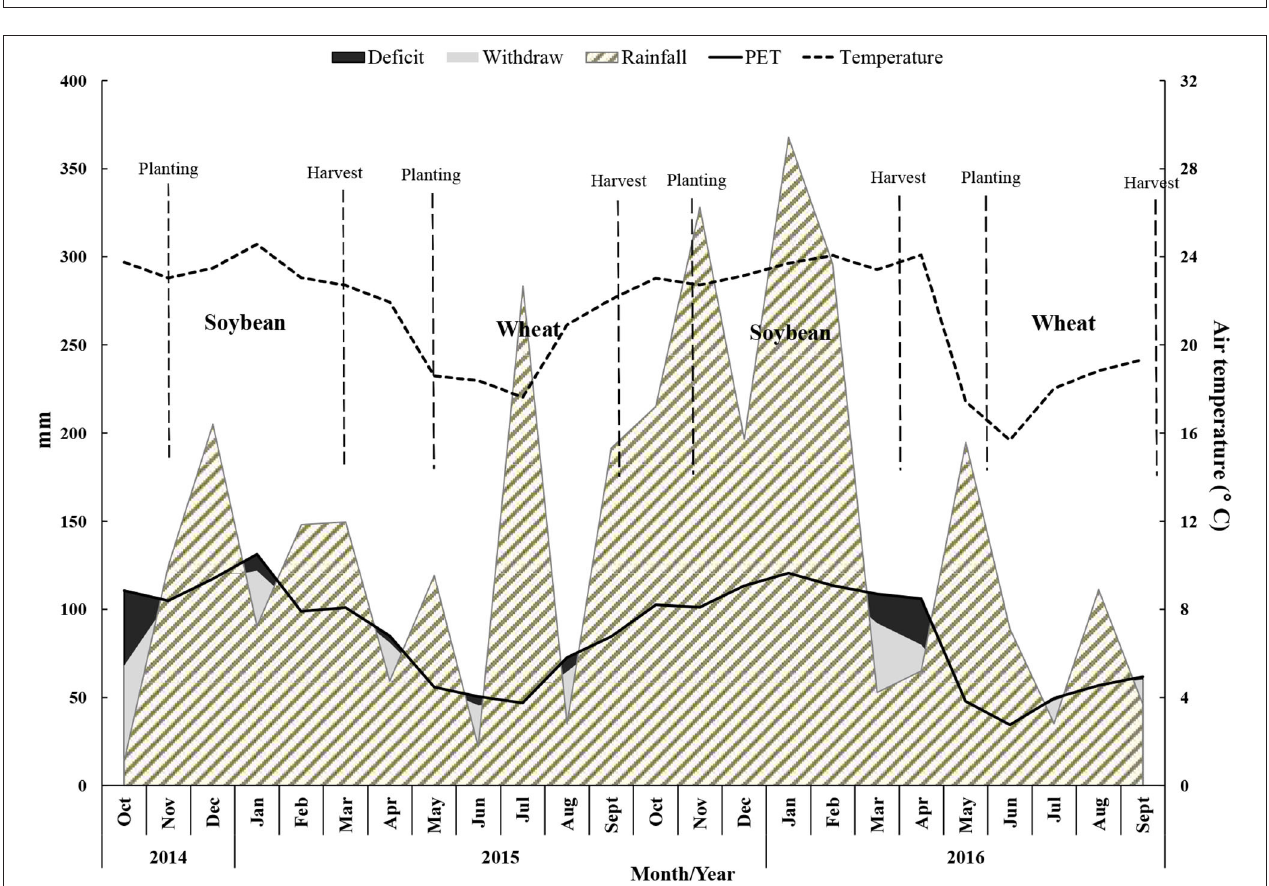
FIGURE 2 | Sequential water balance in the soybean and wheat crop seasons (2014–2016) according to Thornthwaite and Mather (1955). PET, potential evapotranspiration withdraw, H 2 O removal system, and air temperature. Londrina, Paraná State, Brazil.